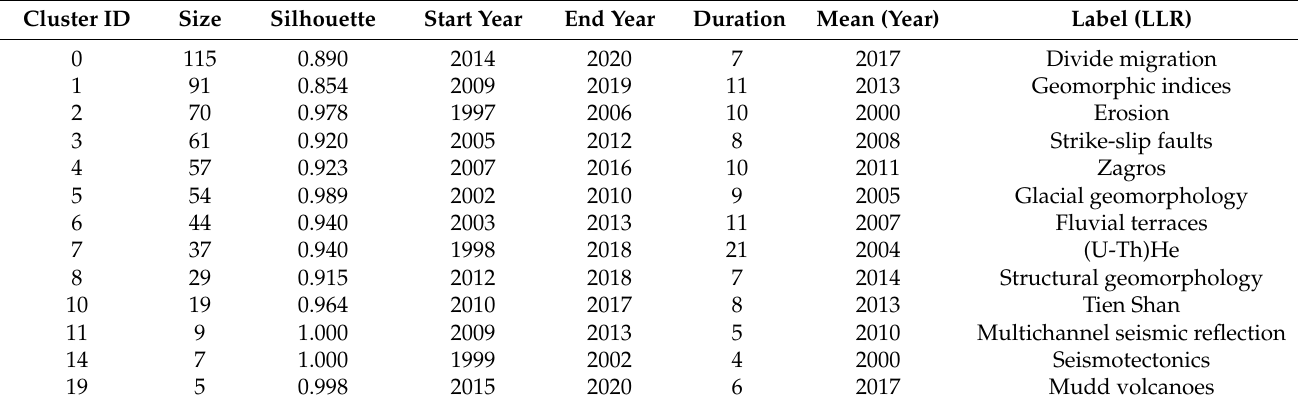
Figure 8. Cluster visualization in timeline view of the tectonic geomorphology research in 1981–2021. The horizontal axis is the timeline (years). The nodes are the cited reference with a frequency and read circles represent the burst. The line between the nodes is the timeline of the reference, and the thickness is the strength [29,30]. Table 8. Reference cluster on tectonic geomorphology research in